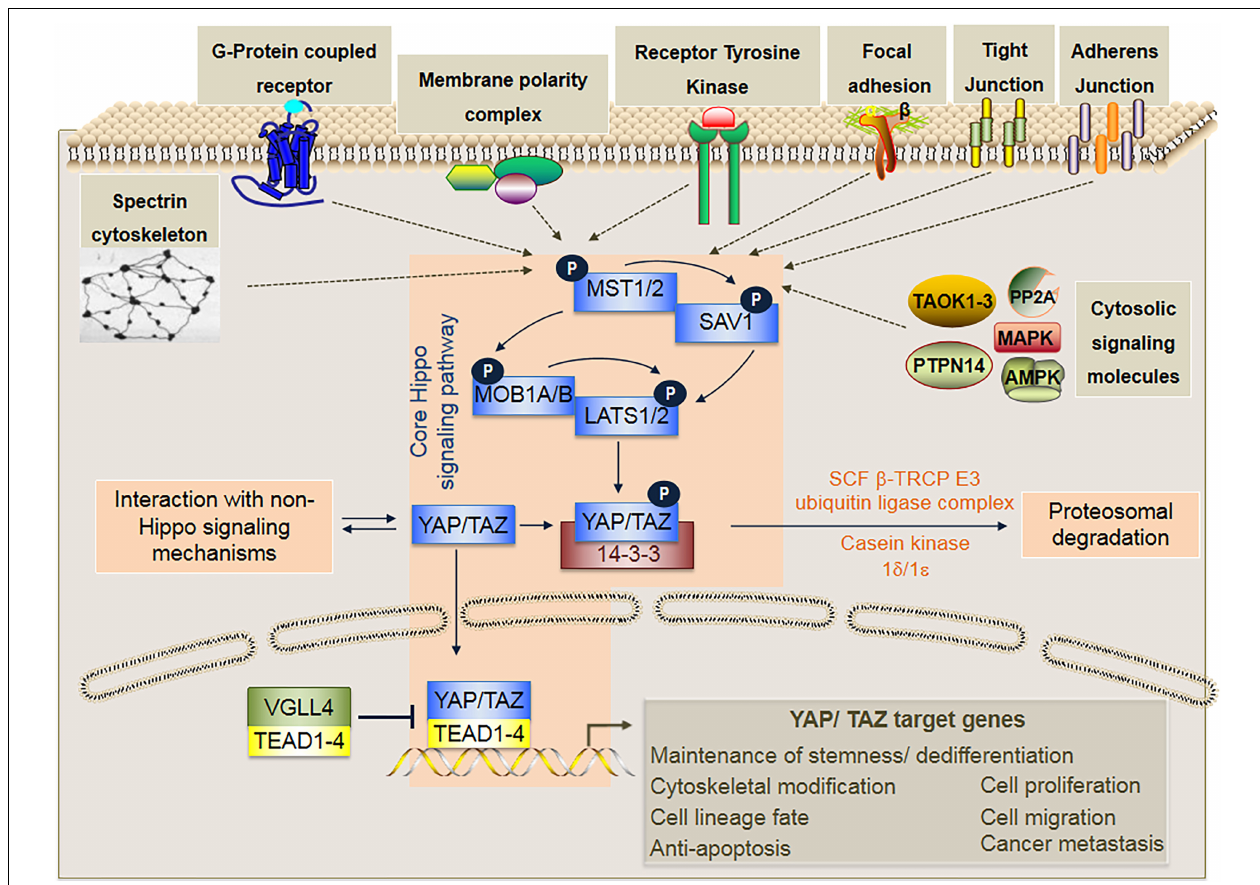
FIGURE 2 | In mammals, the core Hippo signaling pathway is a kinase cascade composed of MST1/2, LATS1/2, SAV1, MOB1A/B, YAP/TAZ, the 14-3-3 protein that binds only to phosphorylated YAP/TAZ, and the TEAD transcription factors (TEAD1-4) that activates transcription of specific target genes upon binding to unphosphorylated YAP/TAZ. Activation of the core Hippo signaling cascade occurs through phosphorylation of either MST1/2 or LATS1/2 by various upstream signaling mechanisms that may involve various cytosolic signaling molecules (i.e., PP2A, TAOK1/2/3, MAPK, AMPK, and PTPN14), Adherens junctions (AJs), Tight junctions (TJs), Focal adhesions (FAs), Receptor tyrosine kinases (RTKs), Membrane polarity complexes (i.e., Crumbs, Scribble, aPKC-PAR) G-protein coupled receptors (GPCRs), and Spectrin cytoskeleton. Phosphorylation of YAP/TAZ inhibits nuclear translocation, and ultimately leads to proteasomal degradation via further phosphorylation of YAP/TAZ by casein kinase 1 δ /1 ε and ubiquitination by the SCF β -TRCP E3 ubiquitin ligase. By contrast, when the core Hippo signaling cascade is not activated, YAP/TAZ remain unphosphorylated and are translocated to the cell nuclei where they bind to TEAD transcription factors (TEAD1-4) and subsequently activate transcription of specific target genes that are involved in diverse cellular functions. Within the cell nuclei, VGLL4 can repress target gene expression by acting as a competitive inhibitor of YAP/TAZ binding to TEAD transcription